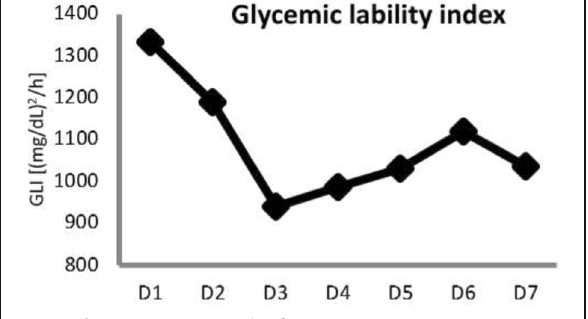
Fig. 1 (abstract 0107). Trends of GLI over D1-D7